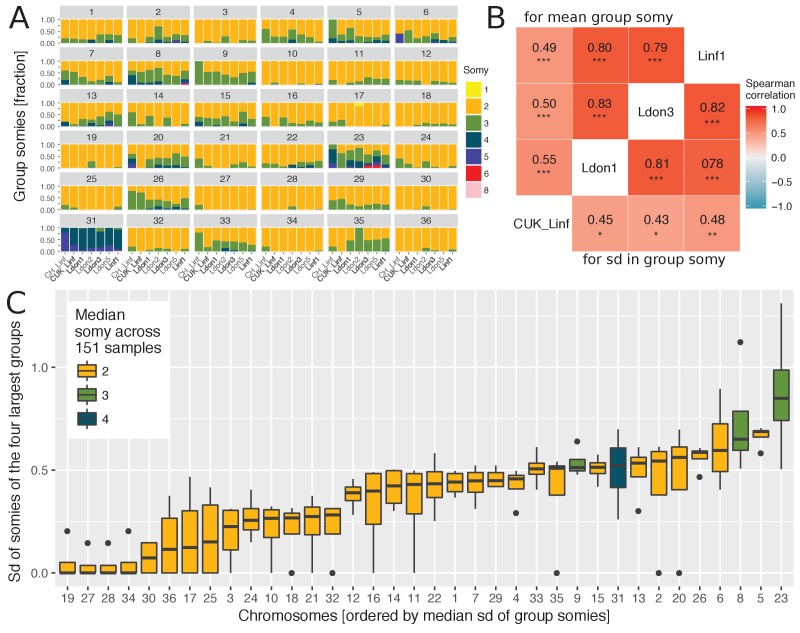
Chromosome-specific somy variability.(A) Somy variability is displayed for the 7 largest groups ( ≥ 5 isolates) for each chromosome as fractions of isolates with the respective somies. The four largest groups ( ≥ 9 samples per group) are indicated in bold. (B) The heatmap shows the Spearman correlations of chromosome-specific somy statistics between the four largest groups, measured as the mean group somies (upper triangle) and the standard deviation (sd) of chromosome somies (lower triangle), respectively. False discovery rates (FDR) of each correlation are indicated by asterisks (*: < 0.05, **: < 0.01, ***: < 0.001). (C) Boxplots show the distribution of variability in chromosome-specific somy across the four largest groups used as independent replicates across the species range. Medians estimate the chromosome-specific variation in somy.